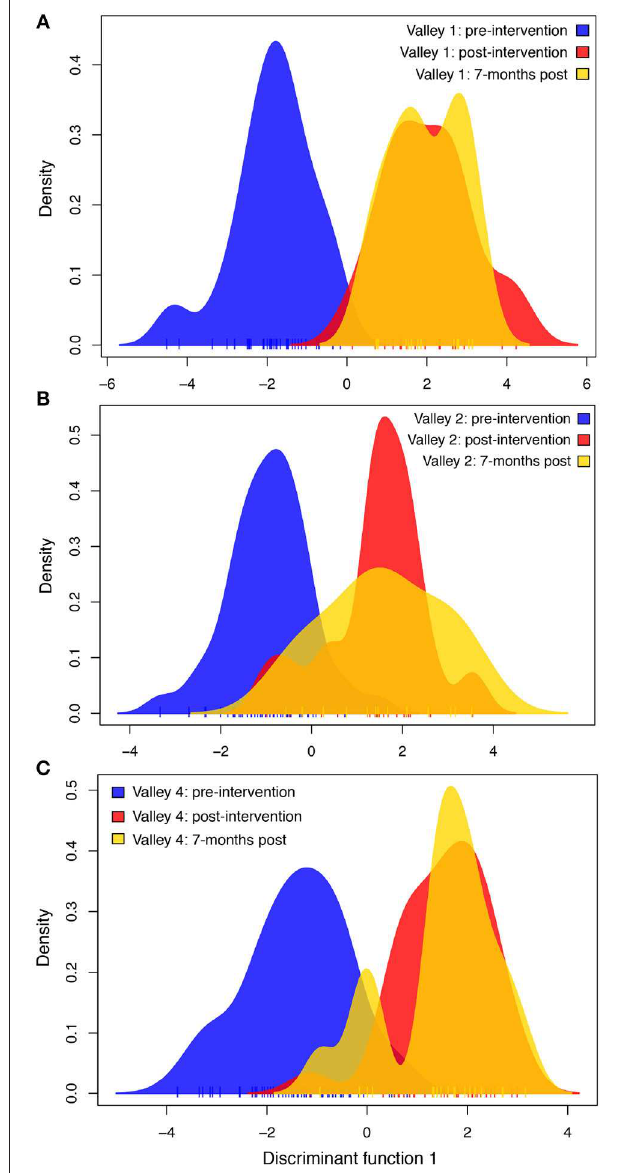
FIGURE 3 | Discriminant analysis of principal components (DAPC) for (A) Valley 1, (B) Valley 2, and (C) Valley 4 at three time points—immediately before the chemical intervention campaign, 1 month following the campaign, and 7 months following the campaign. Each plot displays the first discriminant function on the x -axis, and the density of genotypes on the y -axis. Increasing distance on the x -axis between peak densities represents increasing genetic differences between samples at those time points. In all three valleys, the mean genetic signature of rats shifted after the chemical intervention (i.e., separation between blue curve and the red and yellow post-intervention curves). This difference persisted over the 7 months after the intervention campaign, despite demographic changes in the